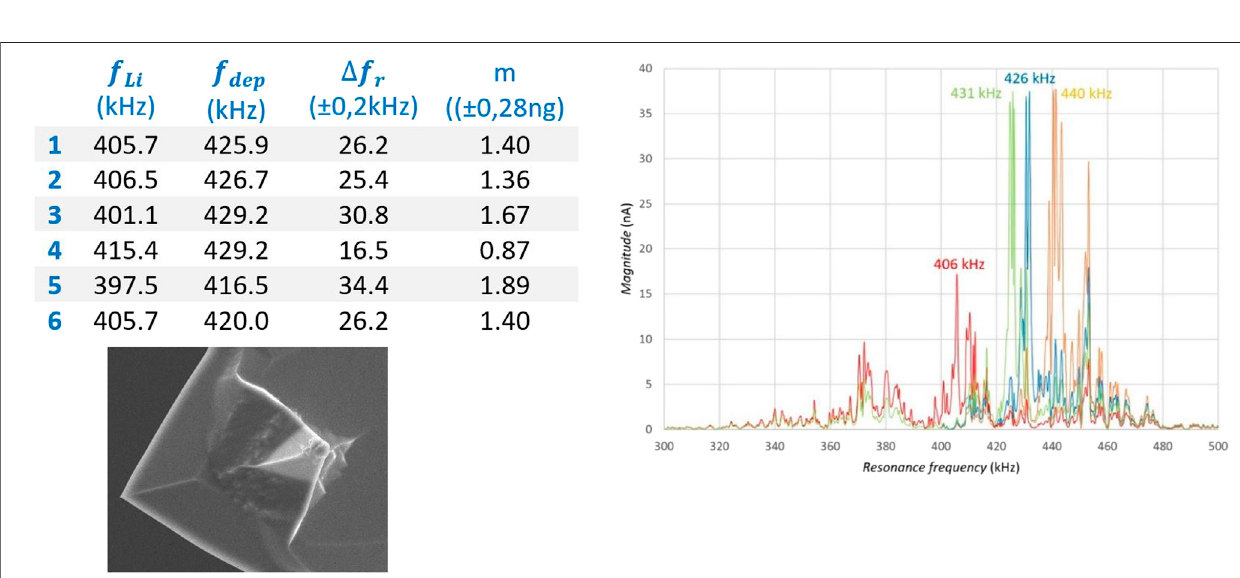
Frontiers in Chemistry |